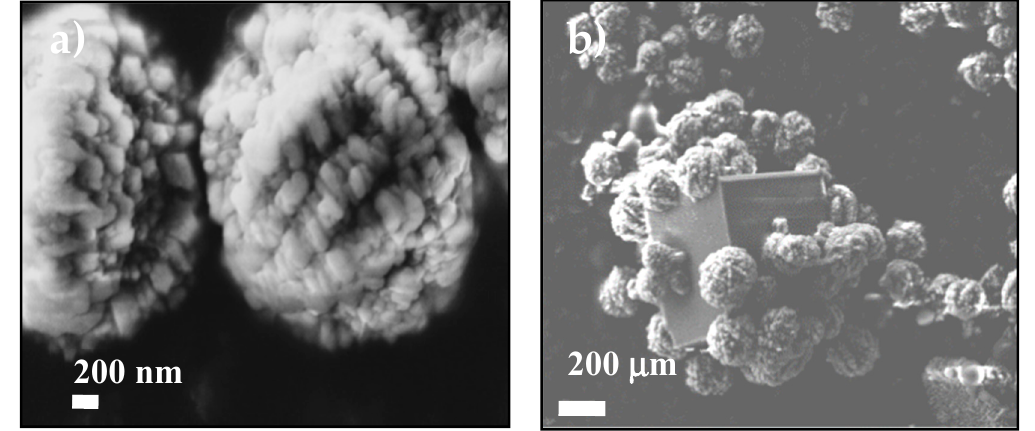
Figure 5. SEM images showing the ACC proto-structures using ( a ) MWCNT-MMI as additive and ( b ) the first calcite crystal surrounded by ACC proto-structures.